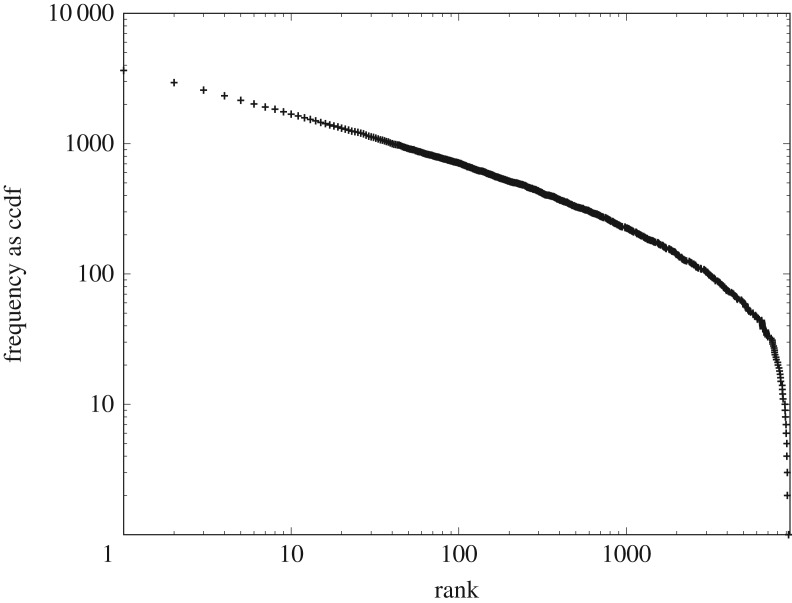
The heterogeneous distribution of software function lengths of figure 6 grouped as a homogeneous distribution and plotted as frequency versus rank.